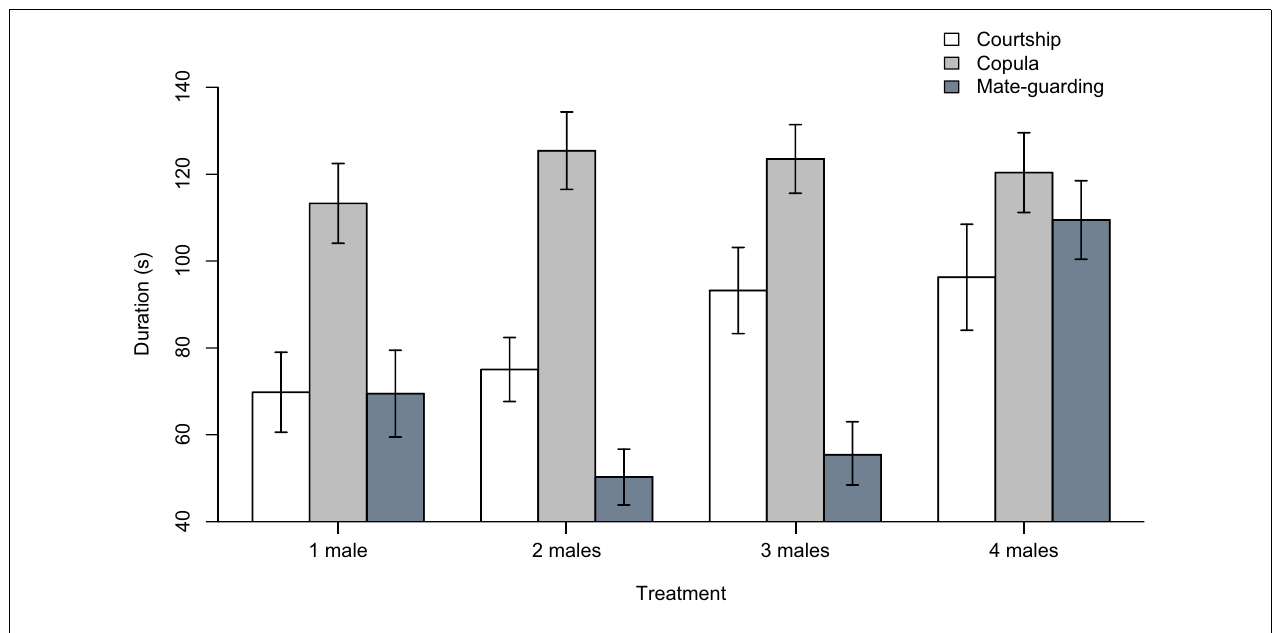
constructed using data that were previously winsorized at α = 0.05 to minimize the influence of outliers (i.e., outliers were replaced by the next highest or lowest value, depending on the tail of the